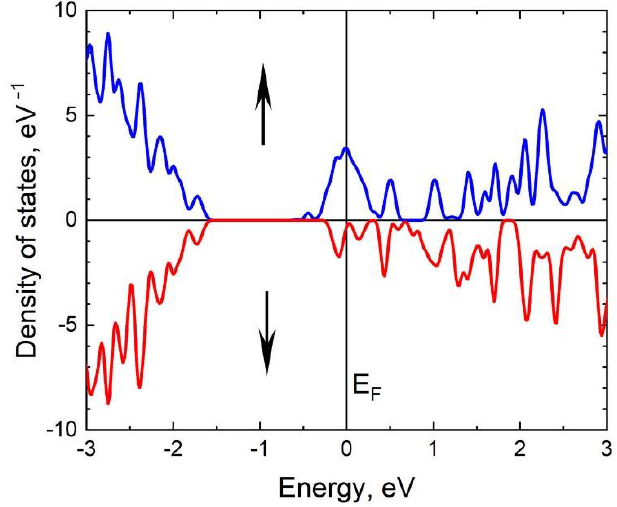
Figure 15. Density of spin-up and spin-down electronic states for system III with n C blue curve in the upper half describes the spin-up electrons; the red curve in the lower half describes the spin-down electrons. The system is a ferromagnetic metal with a spin polarization of 84%.